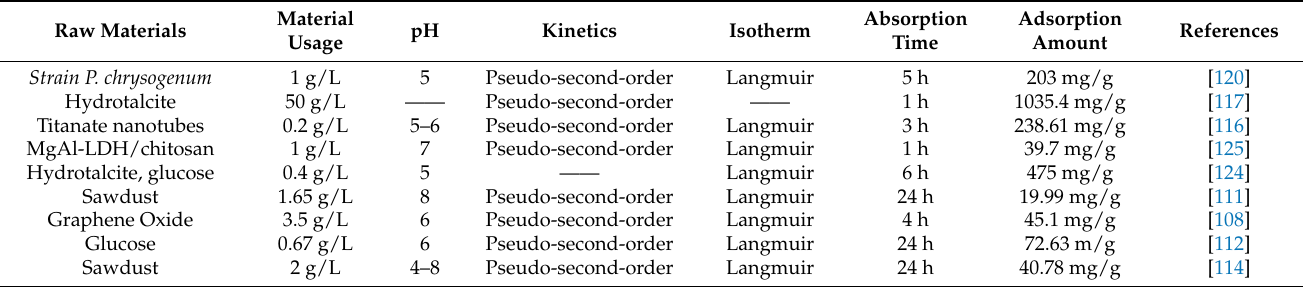
Table 7. Preparation conditions of hydrochar and Cd (II) in adsorption